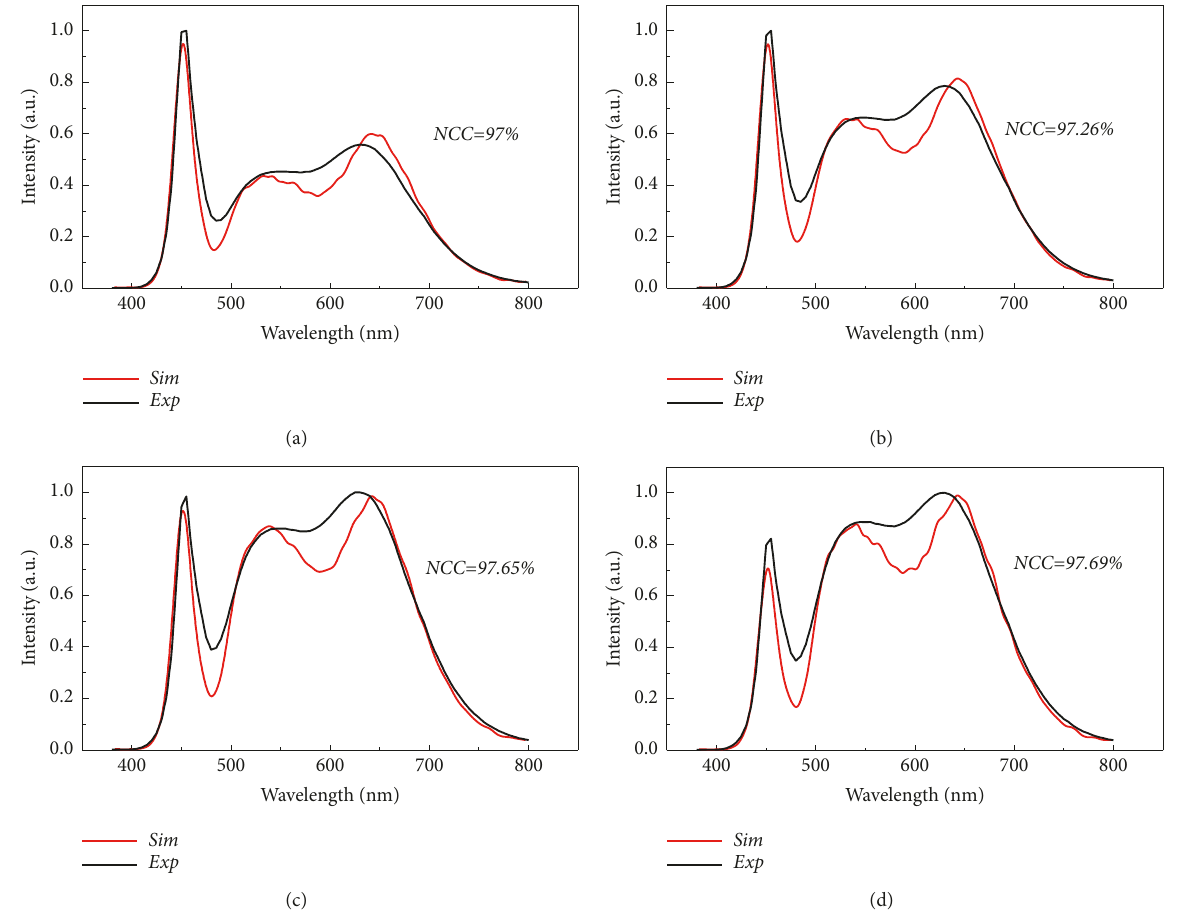
Figure 13: Spectrum power distribution of simulation and experiment at different mass ratios of green and red laminated remote phosphor films: (a) 0.05:0.4; (b) 0.05:0.5; (c) 0.05:0.6; (d) 0.05:0.7.